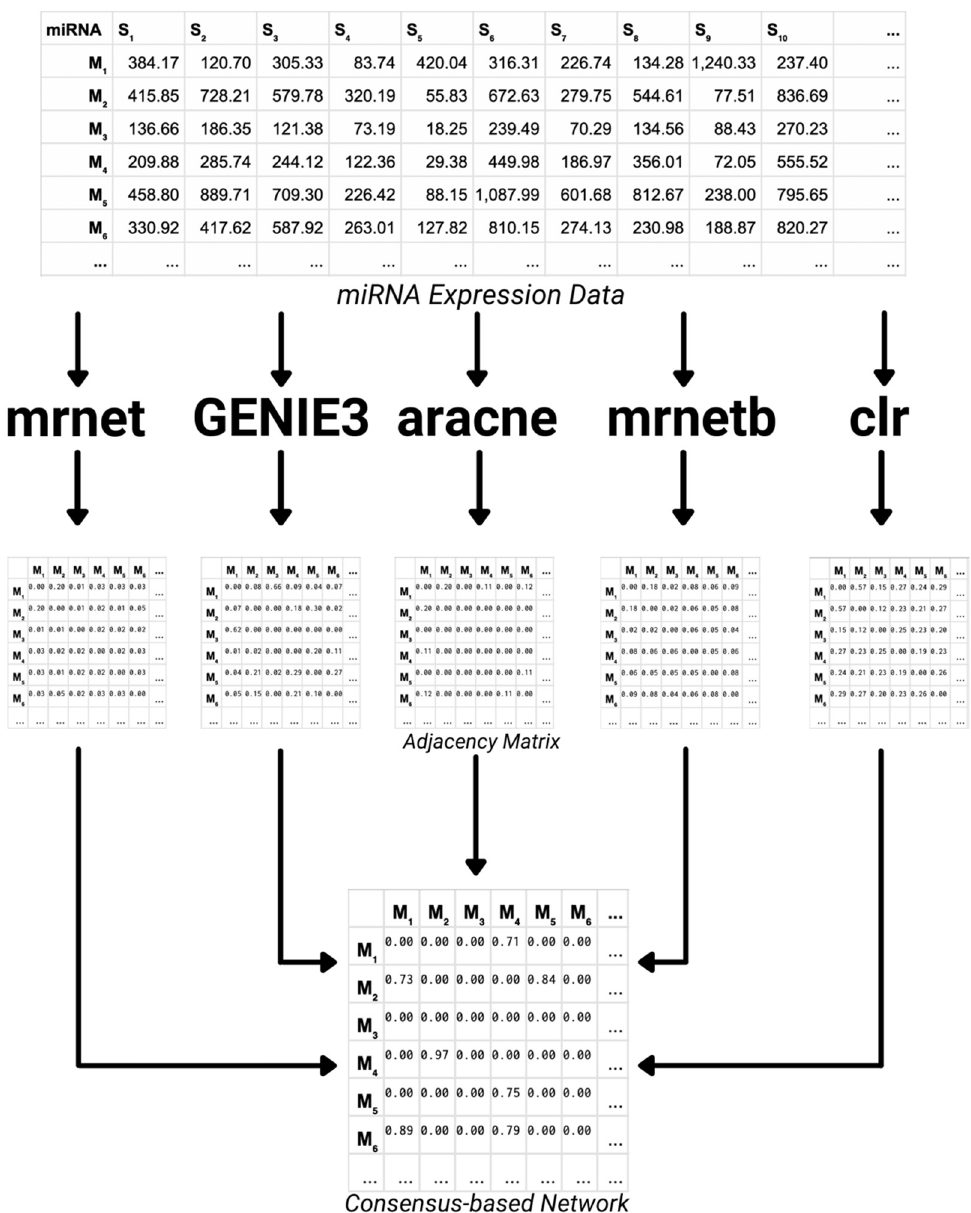
Figure 1. The consensus-based network inference algorithm computes the Consensus Influence Network from the average of five different networks inferred from the miRNA expression data. The GENIE3, mrnet, aracne, mrnetb, and clr network inference algorithms are used to infer five different networks, these are then aggregated into the Consensus Influence Network with a normalized average. The edges of the Consensus Influence Network are then pruned, retaining only edges with a weight higher than 0.7.